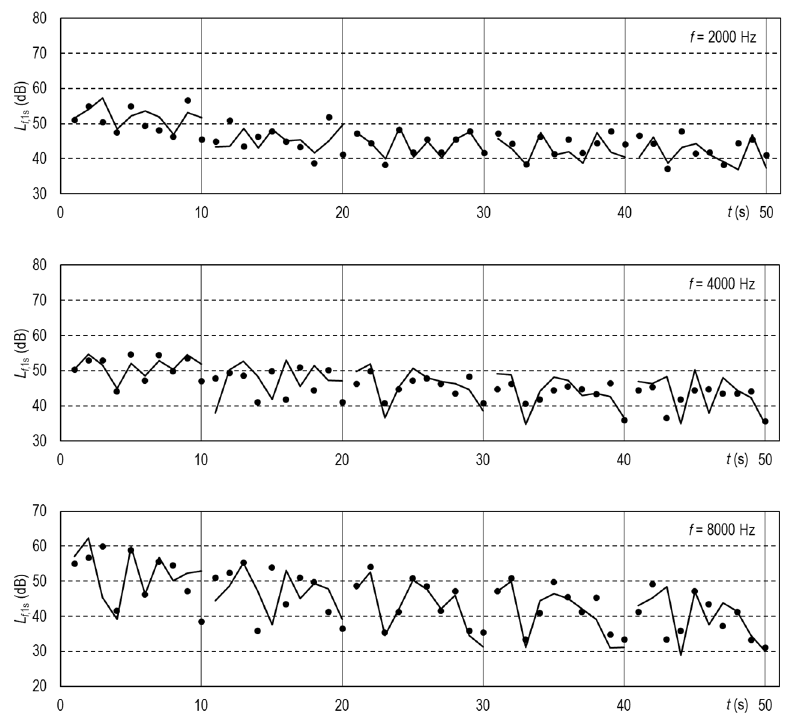
Figure 5. Time series of the sound pressure levels for the FFP3+ in octave bands averaged for 1 s-long intervals. A detailed explanation is in the caption of Figure 4.